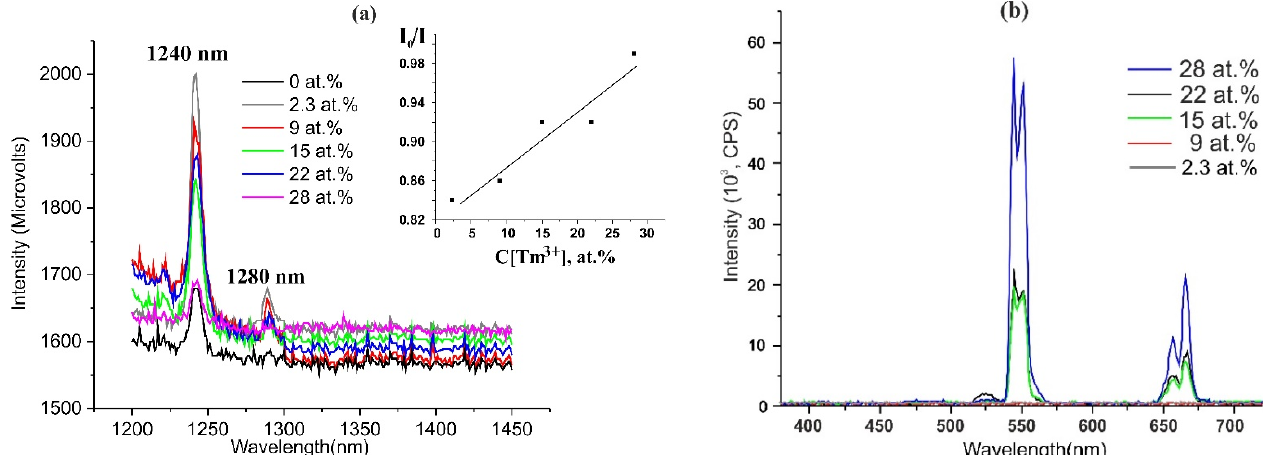
Figure 3. Luminescence spectra in the infrared region ( a ) and upconversion luminescence spectra in the visible region ( b ) of Bi 2 O 3 /Tm 2 O 3 powders with different concentrations of Tm 3+ atoms (2.3–28). The excitation wavelength λ ex = 980 nm, T = 80 K.